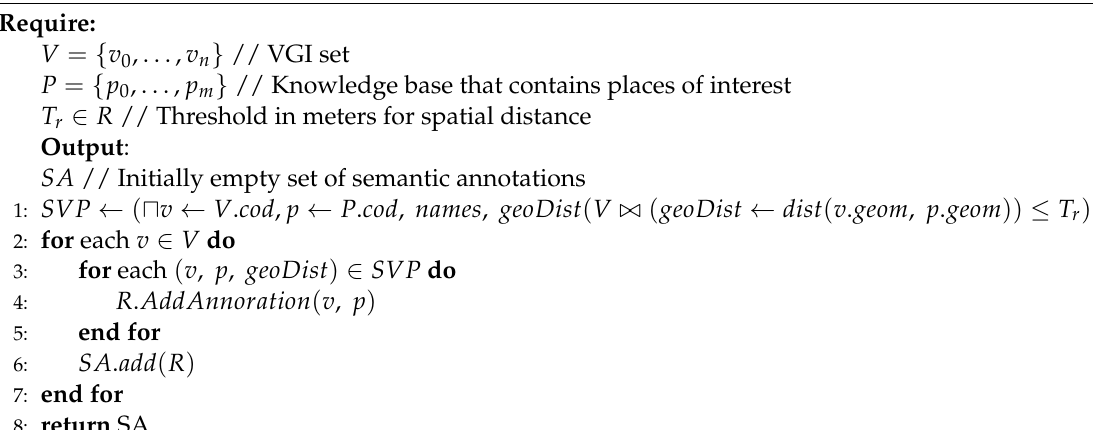
Algorithm 1 Algorithm for automated volunteered geographic information (VGI) enrichment with places of